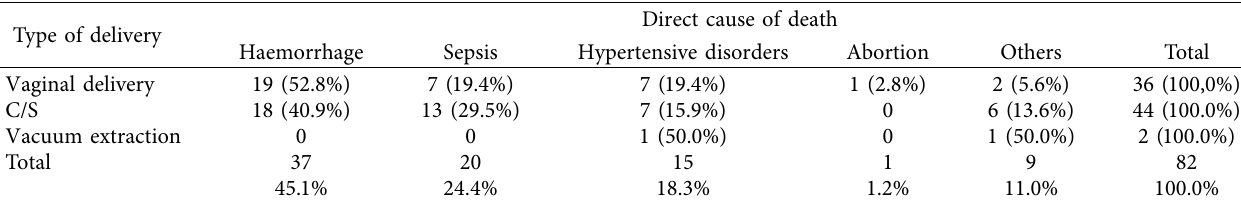
Table 3: Direct cause of death and type of delivery.